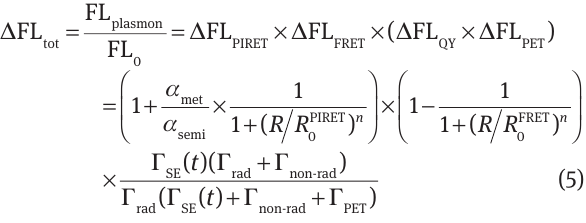
where n = 4–6 depending on whether metal and semicon- ductor dipoles are considered to be surface or point like, α is the wavelength-dependent absorbance coefficient, R is the donor-acceptor distance corresponding to a 0 50% efficiency, Γ ( t ) is the time-dependent radiative rate SE enhancement by the SE in the presence of the plasmon near-field, and Γ is the rate of the photoinduced back- PET ward charge transfer from semiconductor to metal.